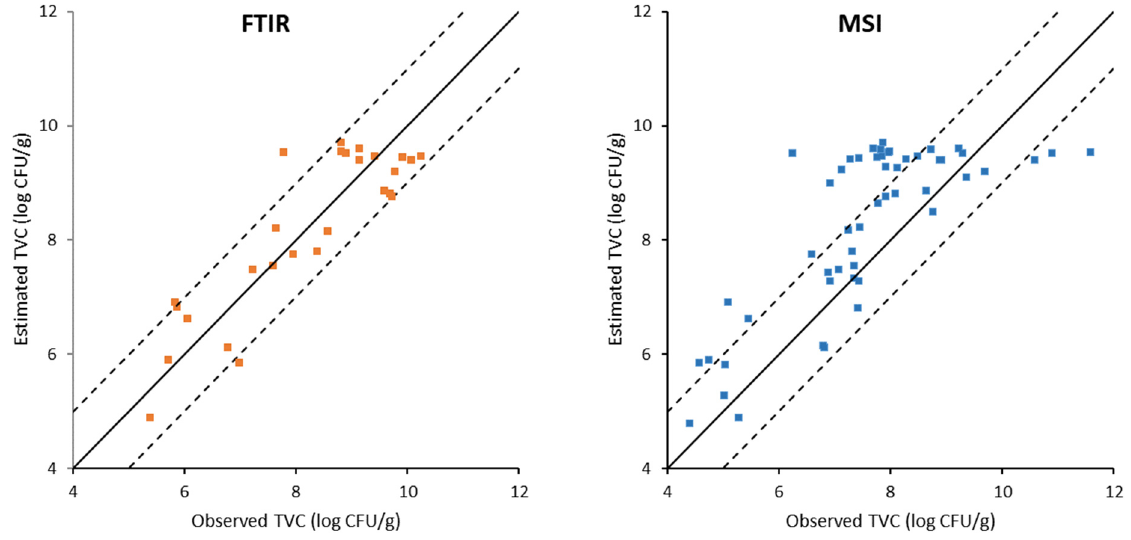
Figure 6. Correlation of observed and estimated values of total viable counts (TVC) on gilthead sea bream fillets during aerobic storage, generated by the PLS-R models based on FT-IR and MSI data. Solid line indicates the line y = x (equity); dashed lines indicate deviation of ± 1 log unit. Table 2. Performance metrics of the PLS-R models developed on FT-IR data for the estimation of TVC in gilthead sea bream fillet samples.